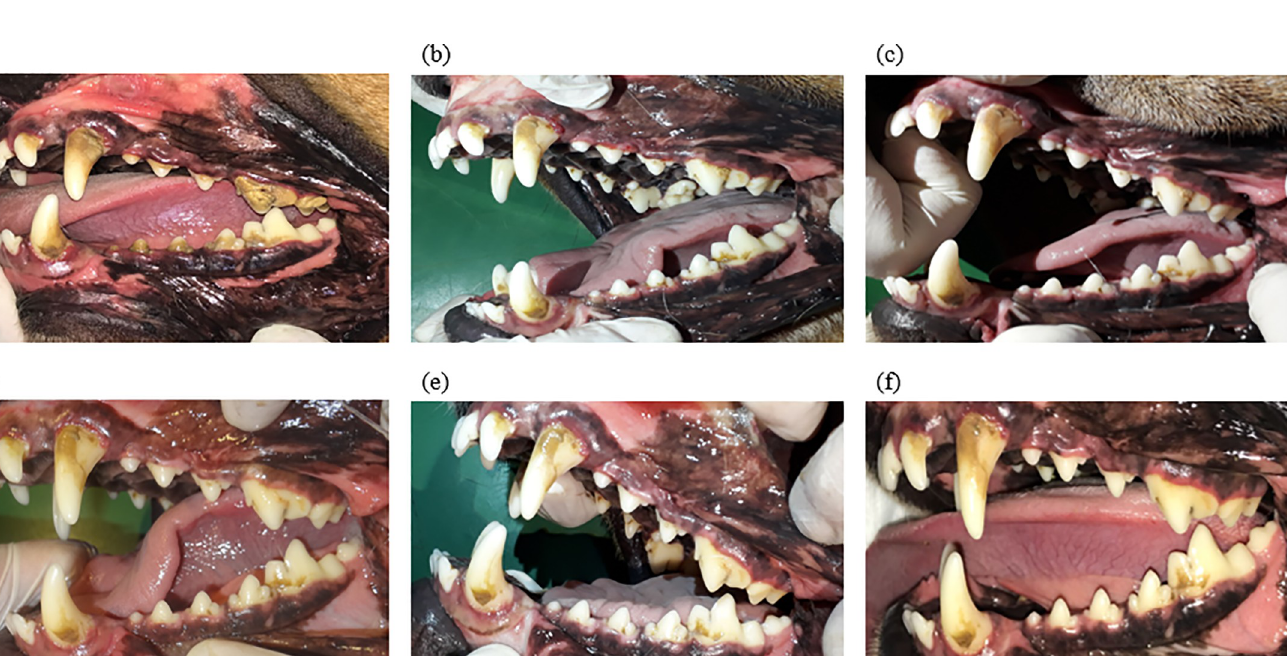
PLOS ONE | https://doi.org/10.1371/journal.pone.0228146 February 13,